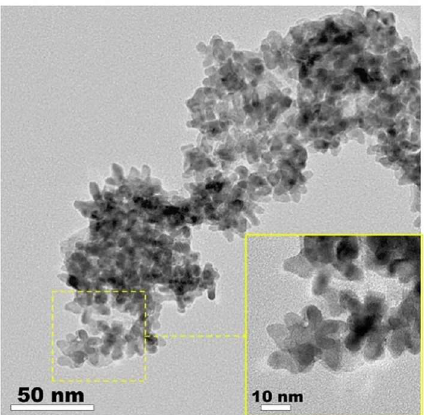
Figure 2. Low-magnification scanning transmission electron microscopy (STEM) micrograph of an agglomerate of Pt 2 NiCo nanoparticles. The inset corresponds to a magnified view of the framed zone (dashed line).